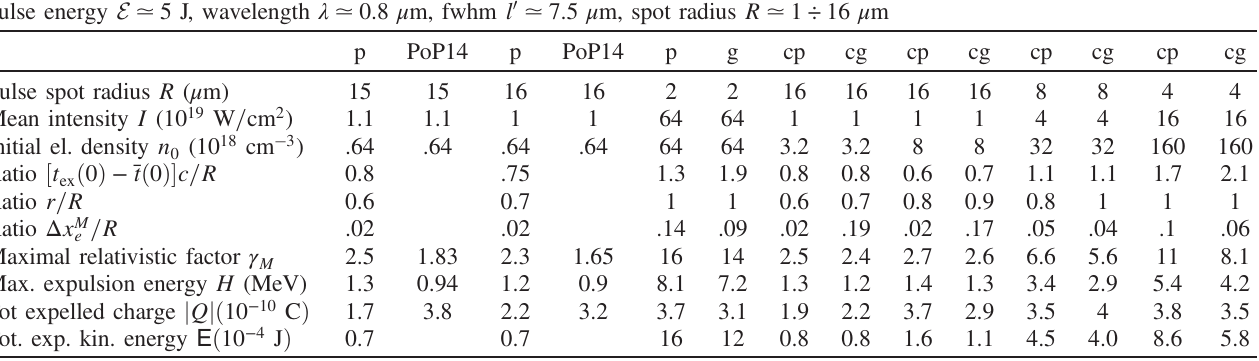
TABLE I. Sample inputs and outputs for possible experiments. In the “ p, g ” columns the initial electron densities are step-shaped, e n θ ð Z Þ , and the amplitudes are resp. of the Gaussian, polynomial forms (39), (40); in the “ PoP14 ” columns we report results 0 ð Z Þ ¼ n 0 computed in [13] with poorer approximation. In the “ cg,cp ” columns the initial electron densities are the continuous ones e n 0 ð Z Þ ¼ n 0 θ ð Z Þ tanh ð Z=L Þ with L ¼ 20 μ m, and the amplitudes are resp. of the forms (39),